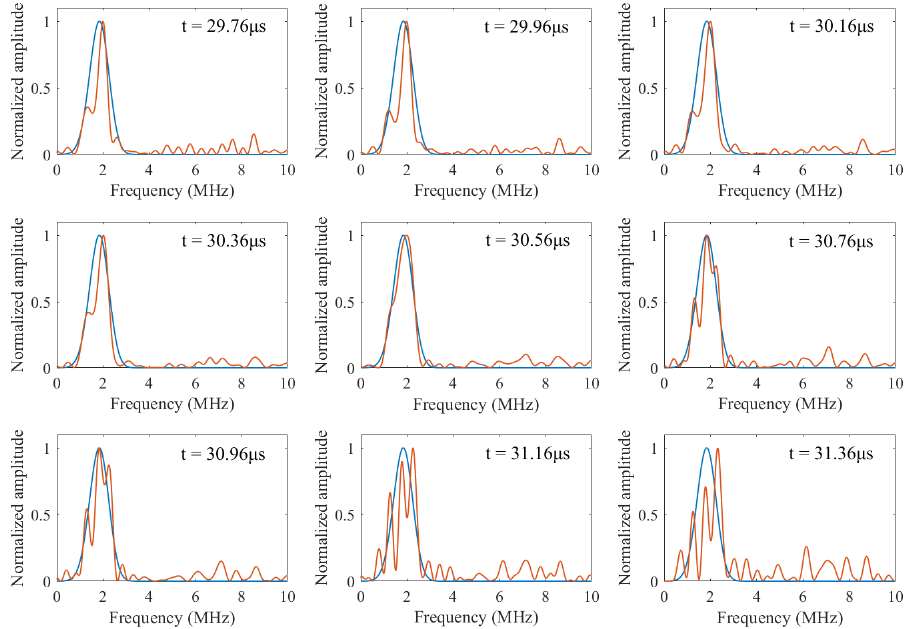
Figure 5. Spectra of time windows adjacent to t = 30.56 μ s along with their corresponding template spectra (solid red line: spectrum of windowed data; solid blue line: template spectrum).